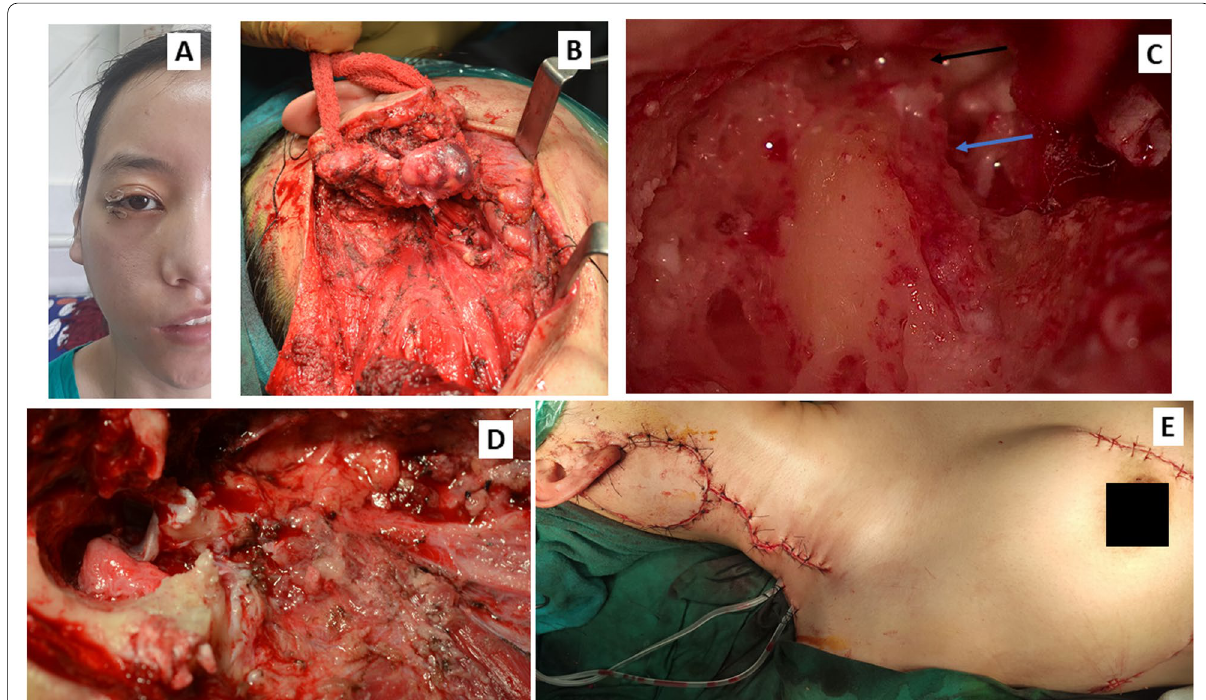
Fig. 1 A Right facial palsy with lateral tarsorrhaphy. B Resected parotid specimen with skin, attached lymph nodes with ligated end of IJV. C Blue arrow: involved part of facial nerve at second genu extending 3 mm into the tympanic segment, Black arrow: normal part of tympanic segment. D Resected lateral temporal bone, mastoid tip, drilled anterior EAC, surgical bed post excision. E Wound closed with PMMC